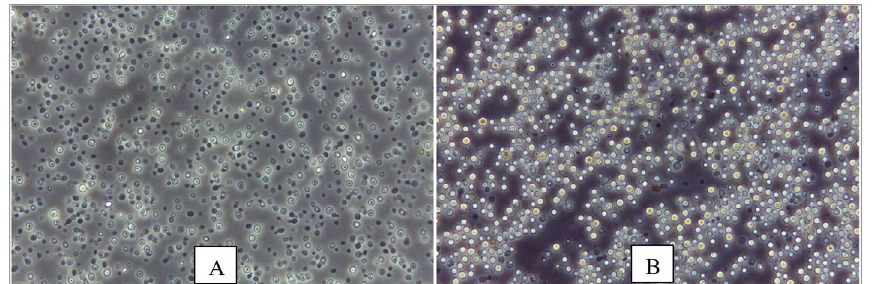
Fig. 6. Phase contrast microscopy of (A) Papiliotrema laurentii (B) Naganishia albida under 40x magnification .